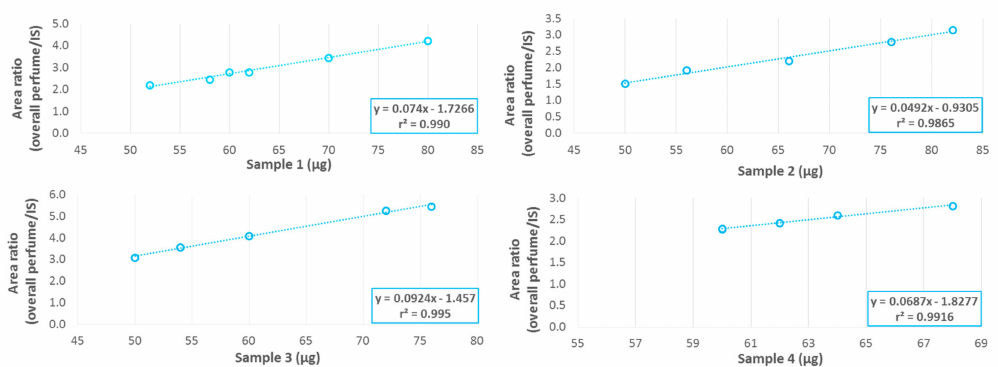
Figure 5. Example of calibration curves obtained by Py-GC-MS for Romascone ® (pink), Verdox TM (green), Lorysia ® (light blue), Cyclosal (orange), Salicynile ® (blue) and the corresponding overall perfume (black) for Sample 1.